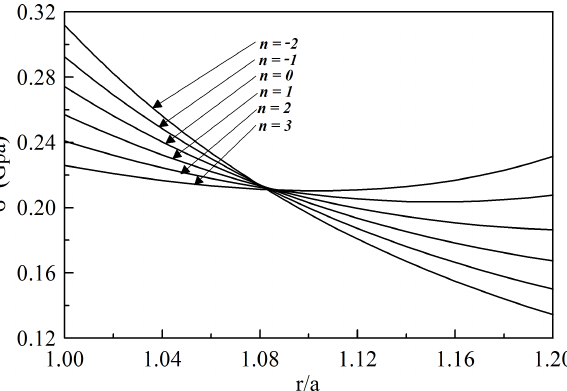
Figure 45: Radially distributed von-Mises stress